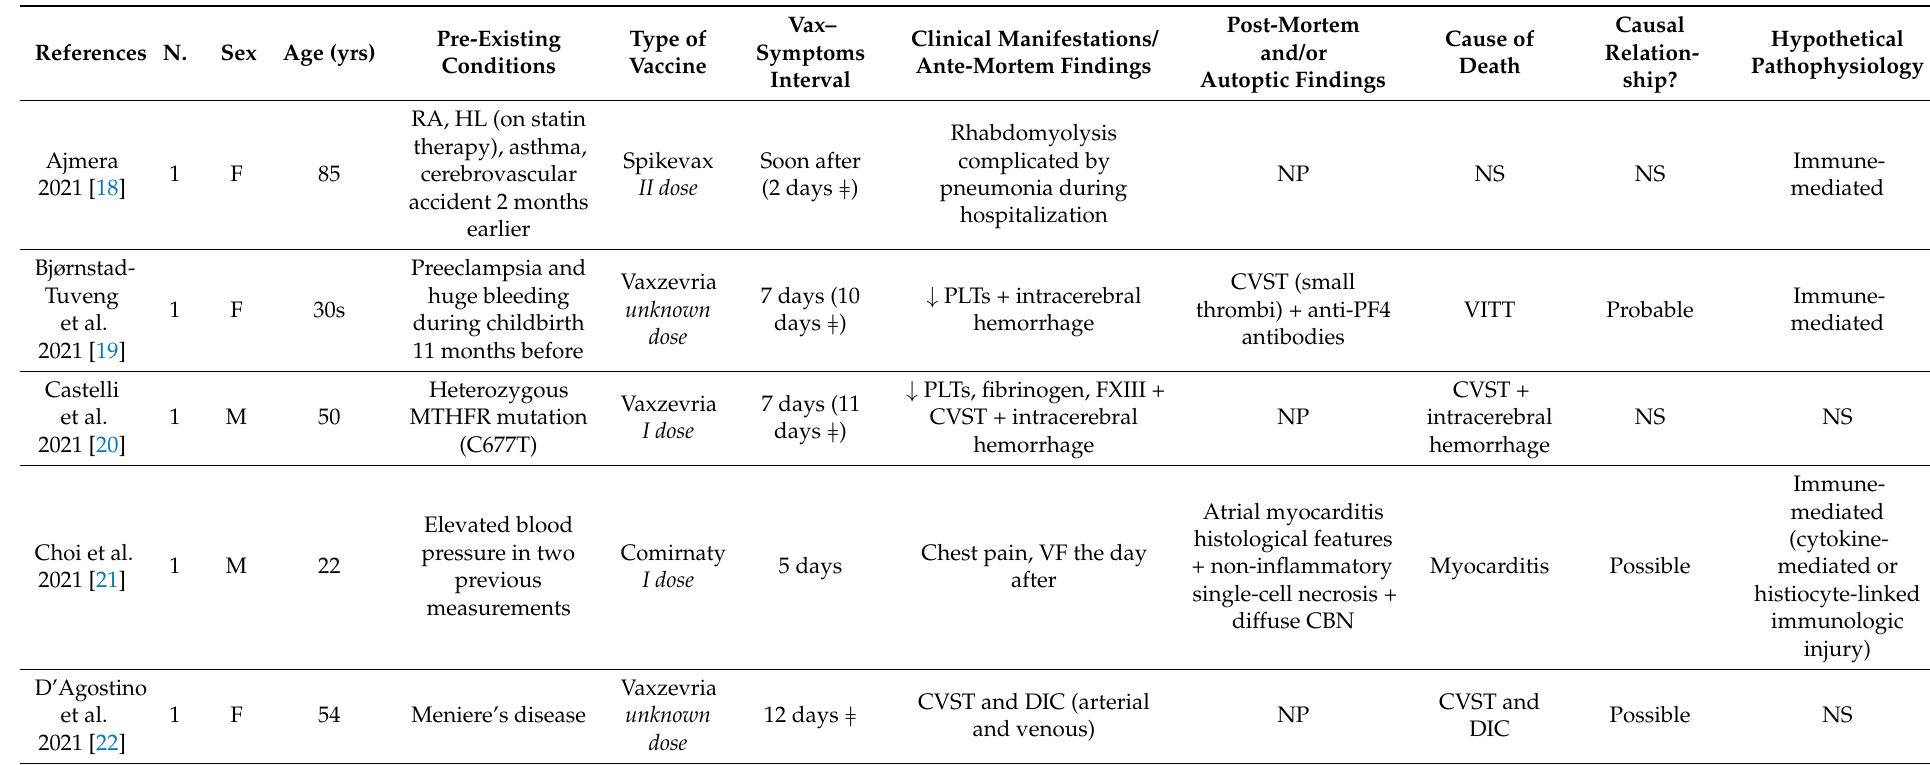
Table 1. A summary of the main information obtained from the results of our literature review. AAT indicates acute aortic thrombosis; ADEM, acute disseminated encephalomyelitis; AF, atrial fibrillation; CBN, contraction band necrosis; CeVD, cerebrovascular disease; CI, cardiac insufficiency; CND, chronic neurologic disorder; COPD, chronic pulmonary disease; COVID-19, coronavirus disease 2019; CRP, C-reactive protein; CRF, chronic renal failure; CSF, cerebrospinal fluid; CVST, cerebral venous sinus thrombosis; DIC, disseminated intravascular coagulation; DM2, type 2 diabetes mellitus; DVT, deep vein thrombosis; FXIII, coagulation factor XIII; FVL, Factor V Leiden; HL, hyperlipidemia; HT, hypertension; IHD, ischemic heart disease; IL, interleukin; LN, lymph node; MI, myocardial infarction; MTHFR, methylenetetrahydrofolate reductase; NP, not performed; NS, not specified; PAD, peripheral artery disease; PAE, pulmonary embolism; PC, pseudomembranous colitis; PF4, platelet factor 4; PSC, primary sclerosing cholangitis; RA, rheumatoid arthritis; SplVT, splanchnic vein thrombosis; SVT, superficial vein